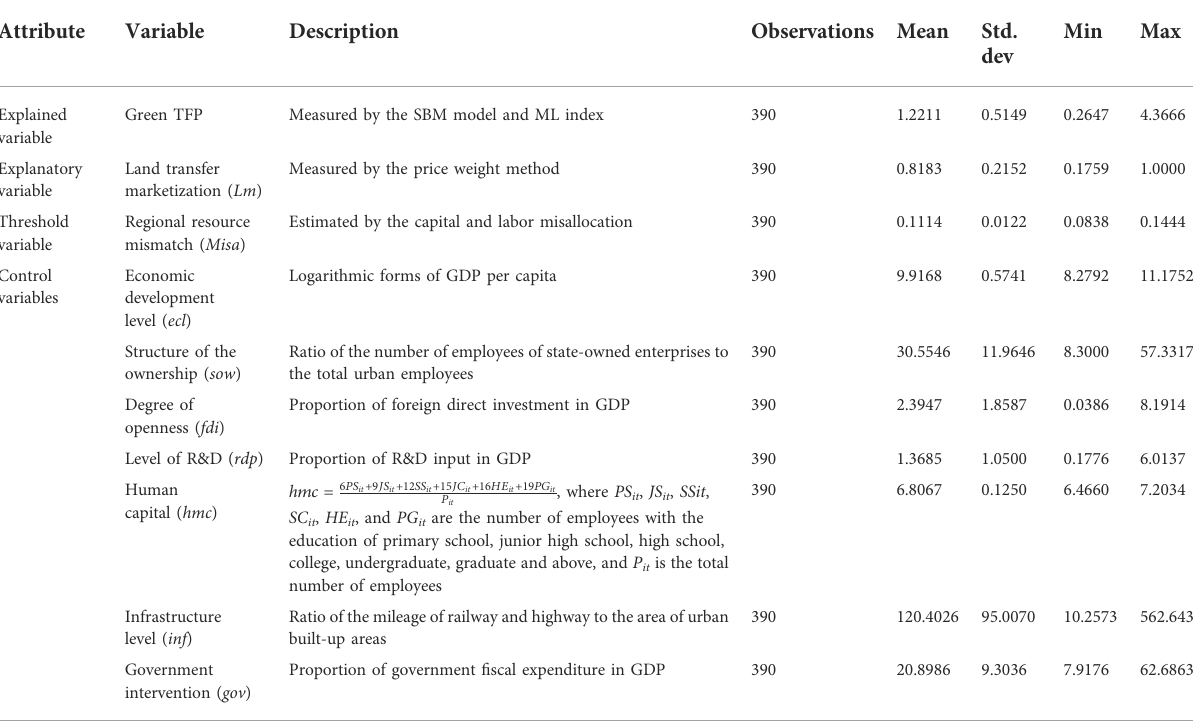
TABLE 1 Descriptive statistics of all the variables in this